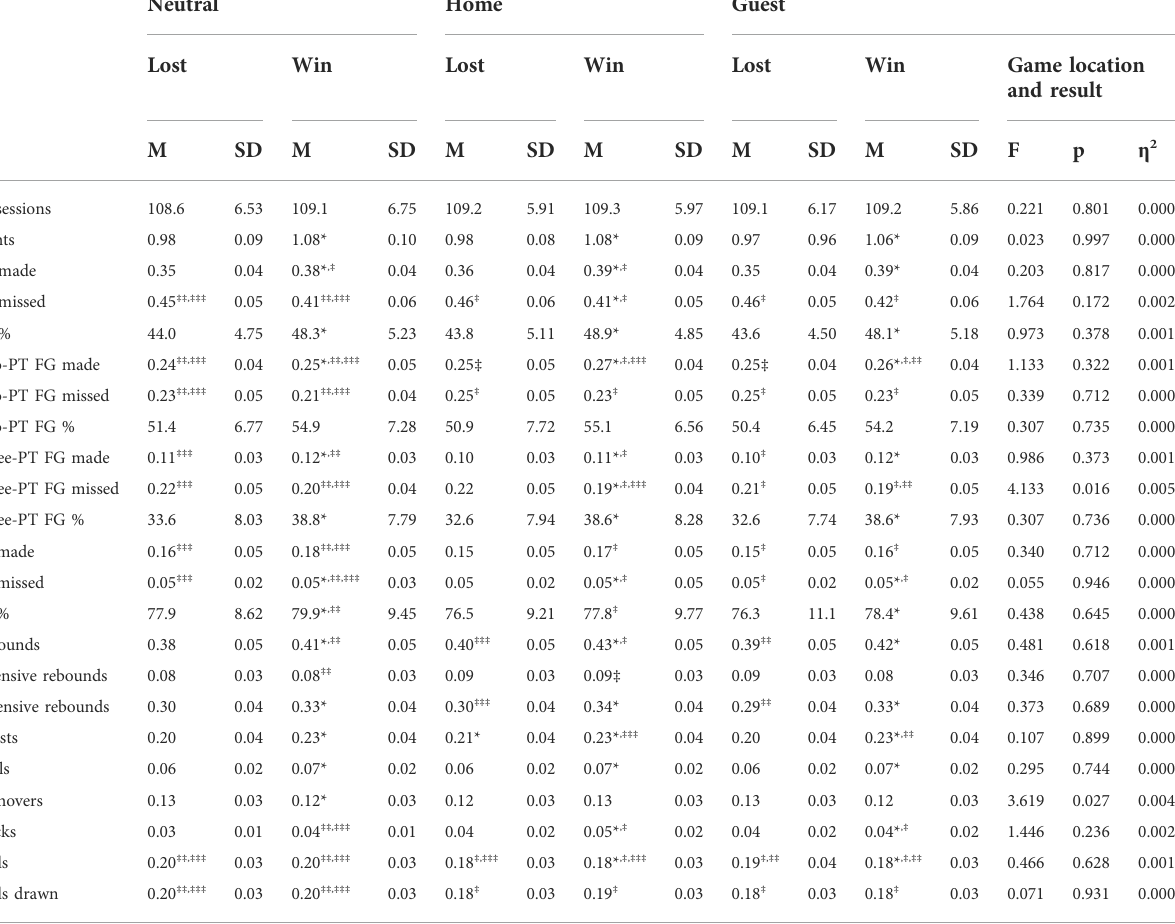
TABLE 2Results of game-related statistics (per possession). Neutral